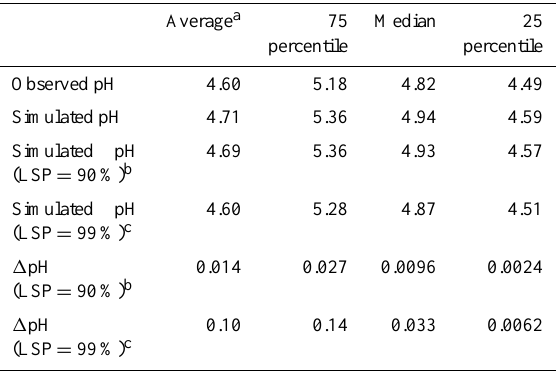
Table 3. Statistical values of observed and simulated daily precipi- tation pH at all the NC stations (Stations